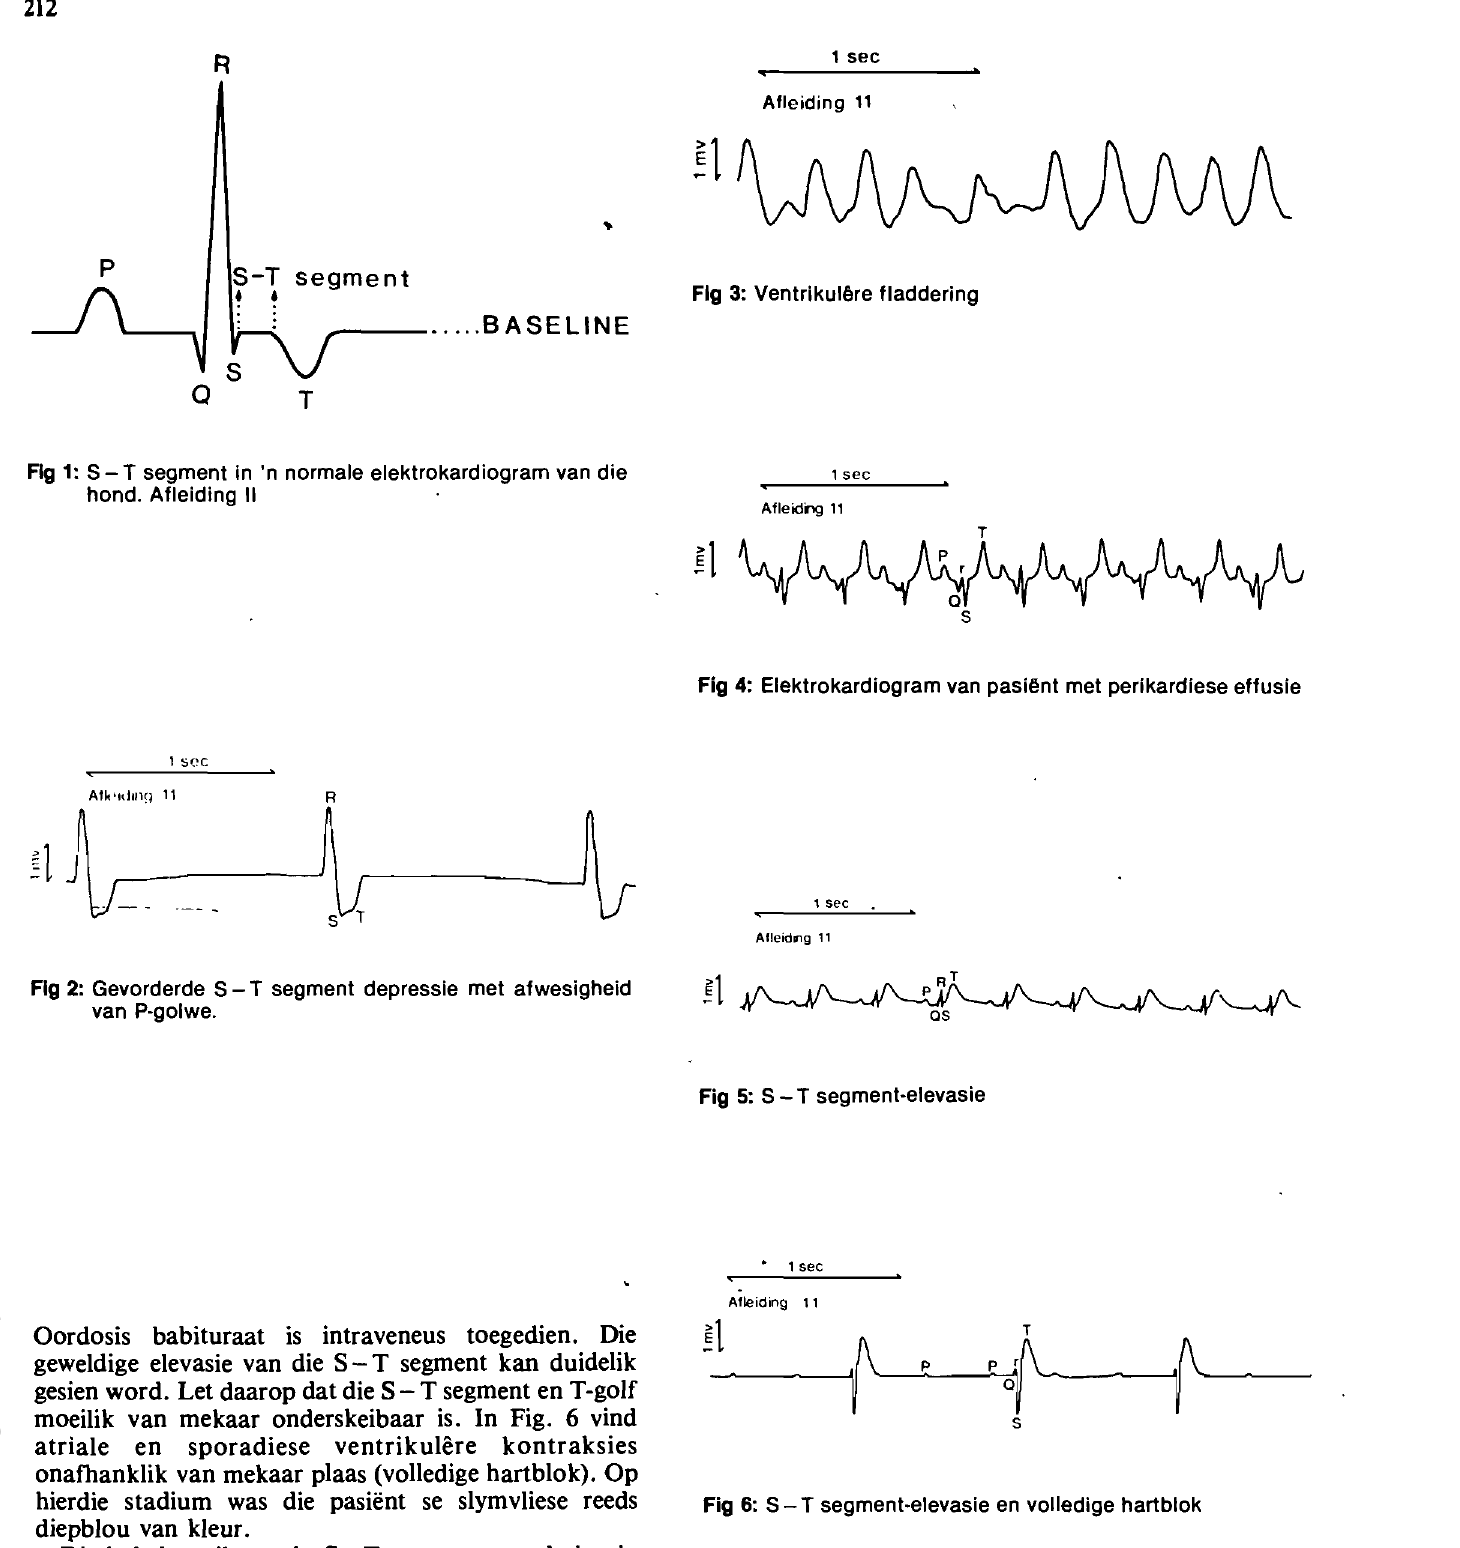
Fig 6: S - T segment·elevasie en volledige hartblok